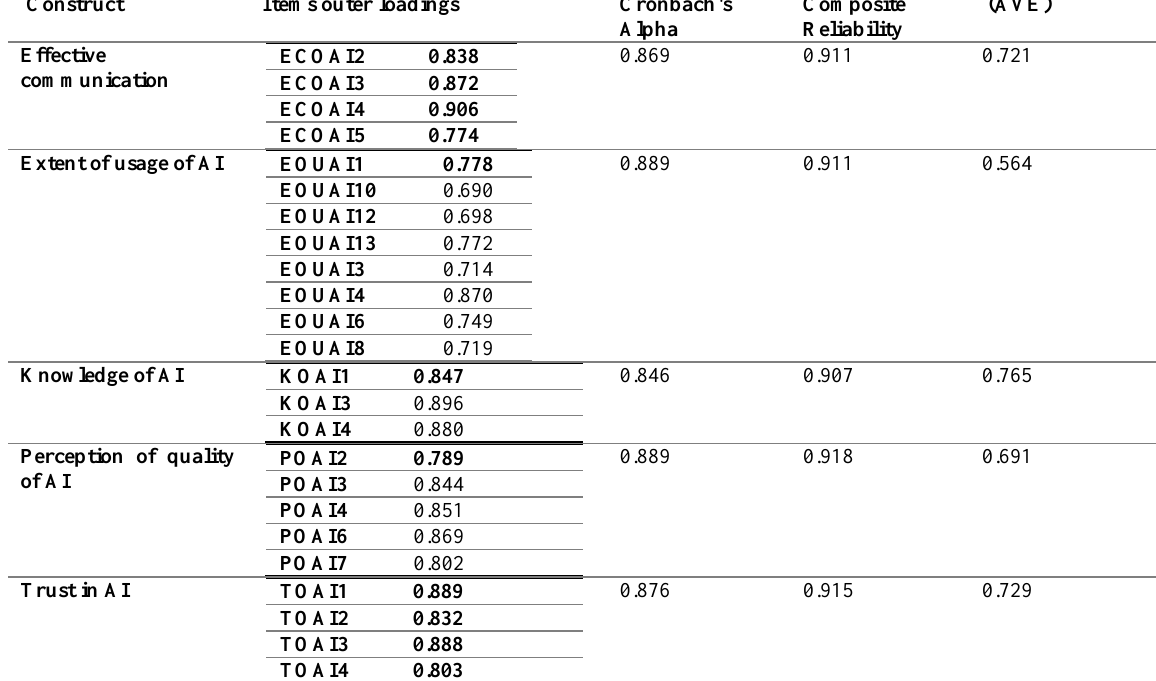
Table 3: Construct Reliability and Validity